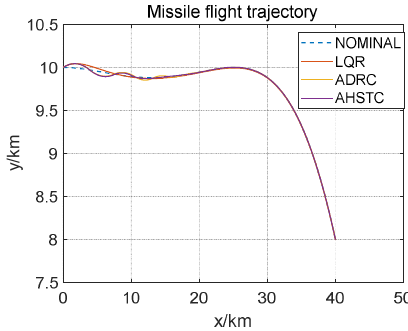
Figure 7. Trajectory tracking curve.